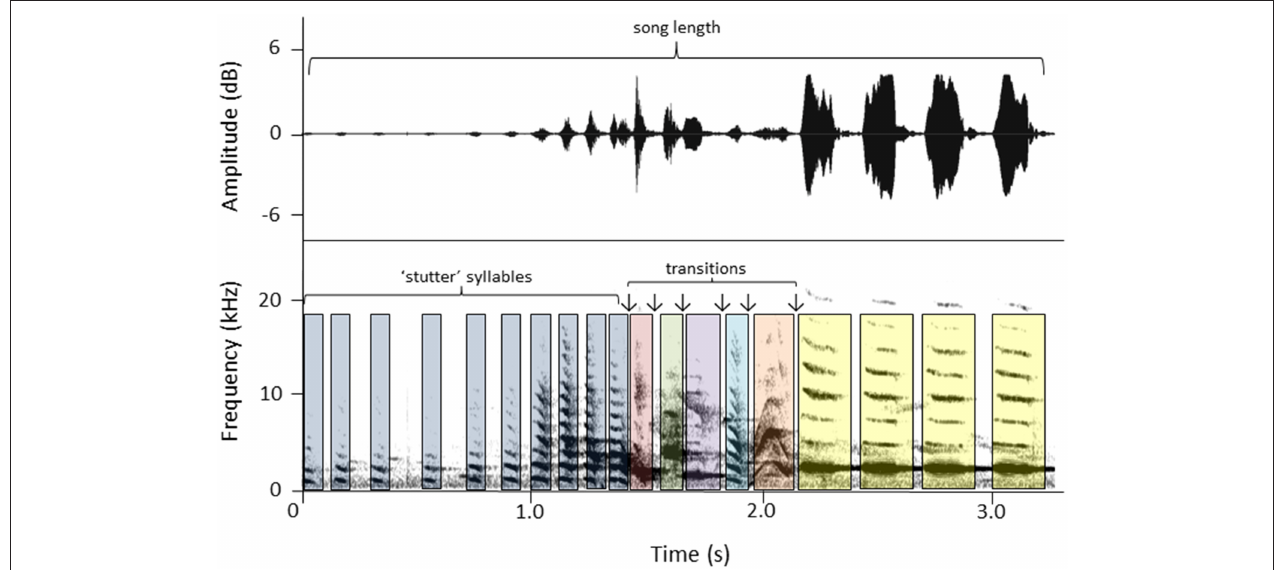
FIGURE 1 | An example of a female song (waveform above, spectrogram below) and the song parameters calculated for each song: song length (s), total number of syllables, syllable types (colors represent different type), number of transitions between syllable types ( ↓ ), and number of stutter syllables. Measures for this song example are: # syllables = 19, song length = 3.19s, # syllable types = 7, # stutter syllables = 10, # syllable transitions = 6.